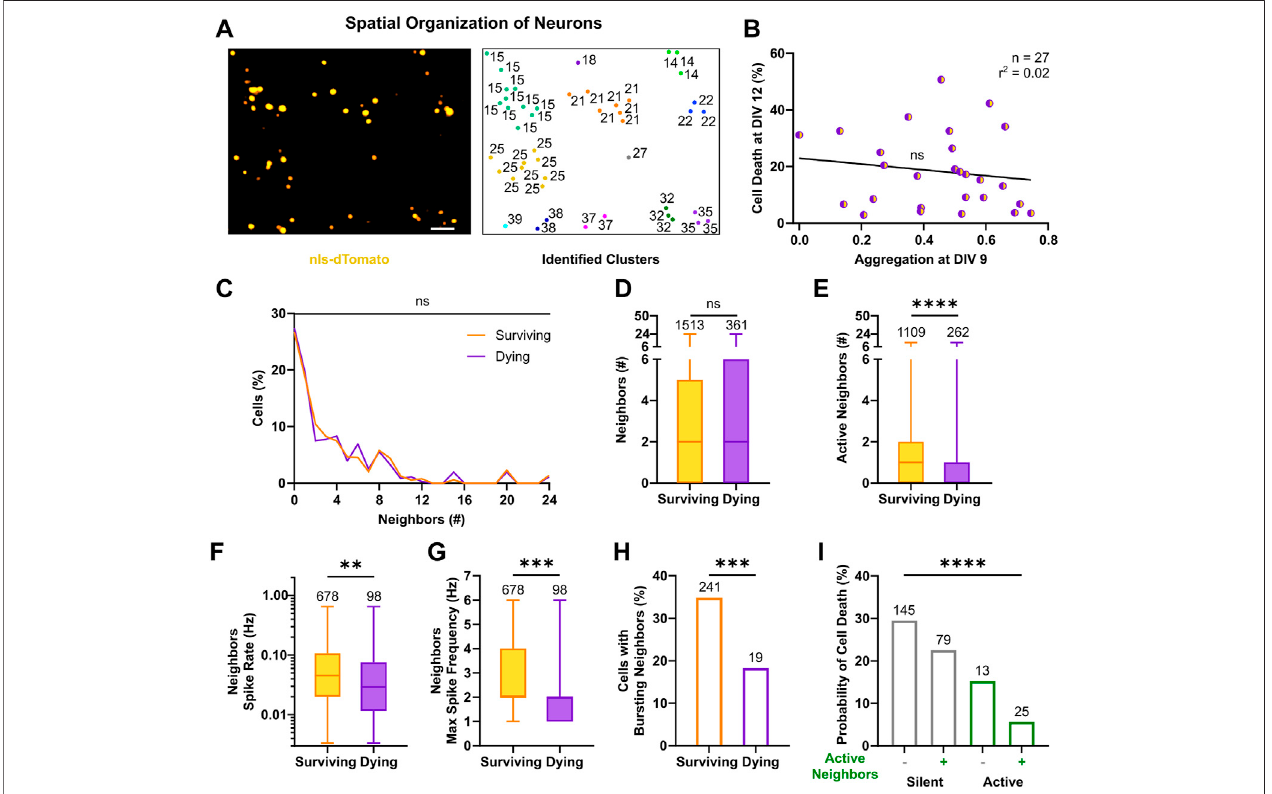
FIGURE 5 | Activity of neighbors in neuronal clusters exerts a pro-survival effect. (A) Identi fi cation of neuronal clusters based on nls-dTomato signal in a representative fi eldofview(left).Neuronsaredepictedbasedontheirphysicalpositionswithrespectiveclusternumber(right).Imagescalebarrepresents50 µm. (B) Cell death rates at DIV 12 were not correlated with respective aggregation indices of cultures at DIV 9 (F test). Line indicates simple linear regression. (C,D) No signi fi cant difference in the number of nls-dTomato-positive neurons in physical proximity (i.e., neighbors < 50 µm) was present between surviving and dying neurons, neither in the relative distributions (Kolmogorov-Smirnov test) nor in the median values (Mann-Whitney test). (E – G) The number of identi fi ed active neighbors, the average and maximumspikeratesofneighborswerehigherinneurons,whichsurvived(Mann-Whitneytest). (H) Therelativepercentageofactiveneighbors,whichdisplayedbursting patterns, was higher for surviving neurons as compared to neurons with a prospective cell death fate (Chi-square test). (I) For silent and active neurons, the presence of active neighbors in their vicinity decreased their probability of cell death (Chi-square test). Box plots with median and IQR and min – max whiskers are shown and ** p < 0.01, *** p < 0.001 and **** p <